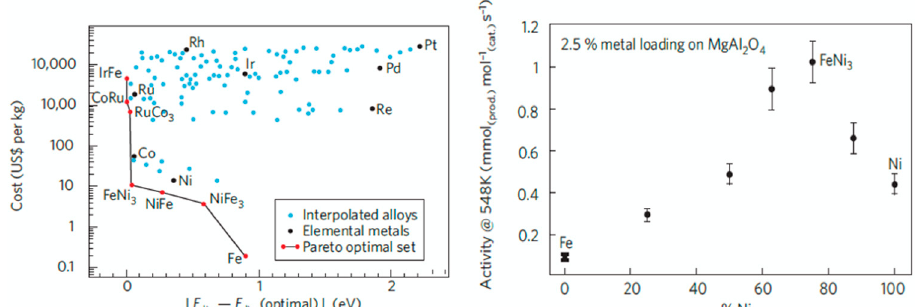
Figure 2. Designing a methanation catalyst. The price vs. the catalytic performance of a single and multicomponent (on the left) bimetallic Fe / Ni combination enables the activity of pure individual element catalysts to be increased (on the right). The catalyst can be optimized by overlapping the price ( left ) and physical synergy ( right ). © Adopted from [50,51].